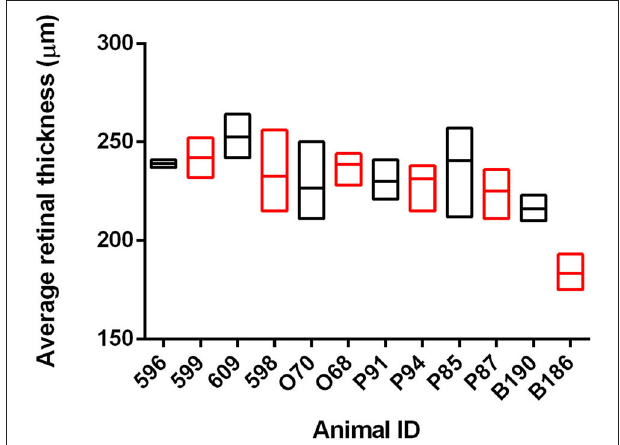
FIGURE 1 | Average retinal thickness ( µ m) in goats naturally infected with scrapie. Average retinal thickness was measured over time in 12 goats using optical coherence tomography. Floating bars represent average retinal thickness over time (min/max) of scrapie-positive animals (red, n = 6 animals/18 measurements) compared to age-matched control animals (black, n = 6 animals/21 measurements) from at least two time points. Refer to Supplementary Table 2 for further